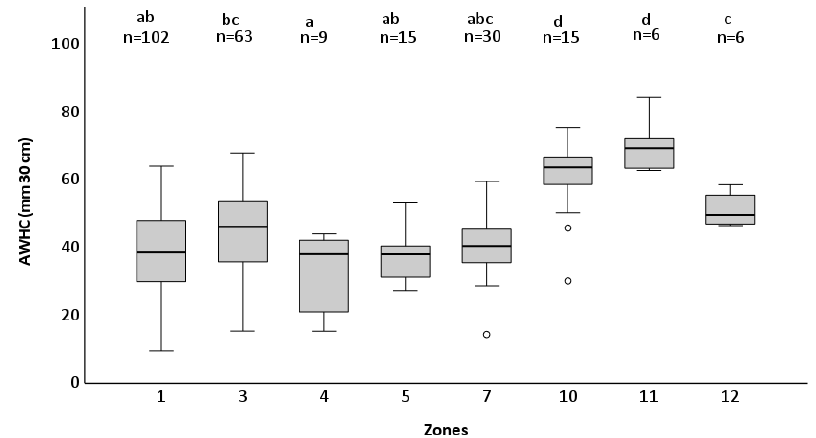
Figure 4. Volumetric soil AWHC (0–30 cm) in each of the zones selected for this study. Center lines show the medians, box limits indicate the 25th and 75th percentiles, whiskers extend 1.5 times the interquartile range from the 25th and 75th percentiles, outliers are represented by dots. Values marked with different letters are significantly different ( p < 0.05) according to ANOVA. Values showing the same letter belong to the same homogeneous group according to Duncan’s test. Open circles are outliers.